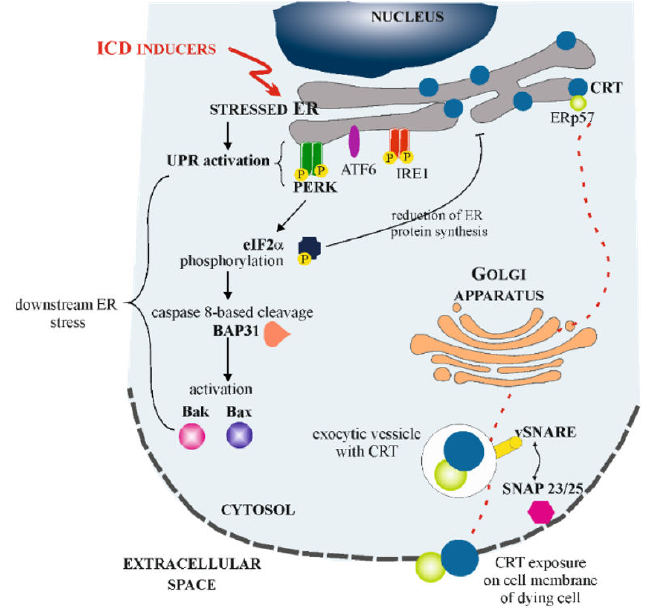
Figure 3. Mechanism of calreticulin (CRT) exposure in the response to immunogenic cell death (ICD) inducers. After exposition of cells to stress factors causing ICD, the loss of ER homeostasis leads to activation of unfolded protein response (UPR) signaling pathways. During ICD, protein kinase R-like endoplasmic reticulum kinase (PERK) activation leads to the phosphorylation of α -subunit of eukaryotic initiation factor 2 (eIF2 α ), inducing the downstream ER stress: pre-apoptotic, caspase 8-based cleavage of B-cell receptor-associated protein 31 (BAP31) and activation of BCL2-associated X protein (Bax), as well as Bcl-2 homologous antagonist/killer (Bak). Finally, CRT that has transited to the Golgi apparatus is exocytosed through soluble N-ethylmaleimide-sensitive fusion protein- attachment protein receptor (SNARE)—dependent pathway. Exocytic vesicles fuse with plasma membrane by interactions between SNAREs related with vesicles and synaptosome associated protein 23/25 (SNAP23/25) associated with cell membrane and CRT is exposed on the cell membrane of dying